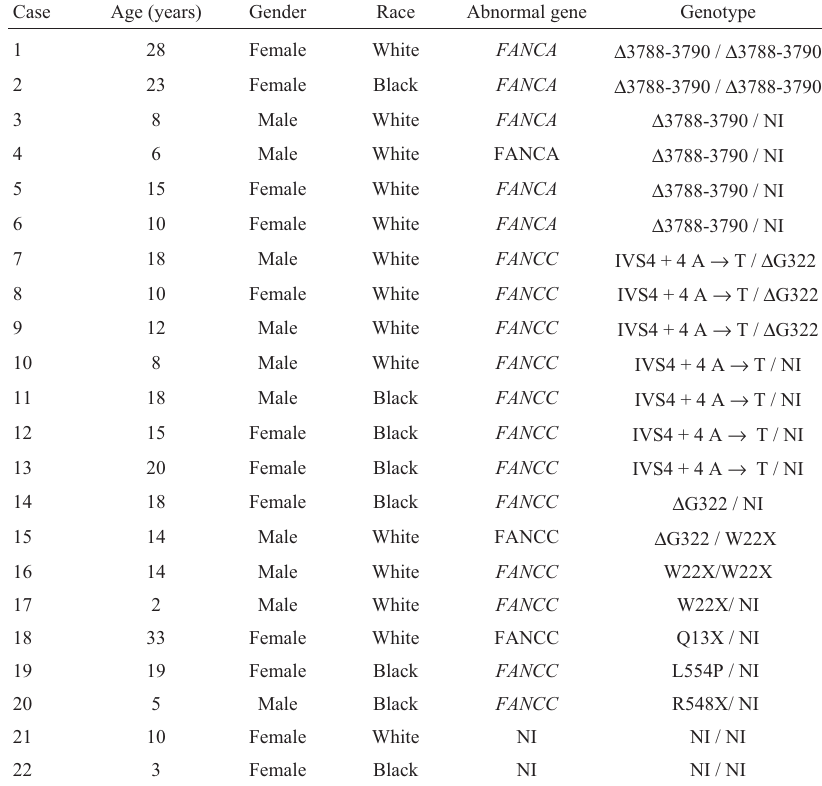
Table 2 - Clinical and molecular features of 22 patients with Fanconi